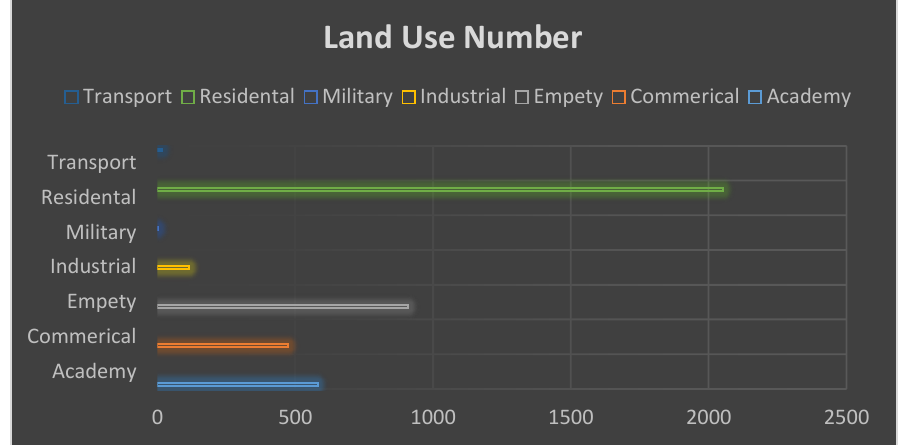
Fig. 4. Number of parcels per land use.